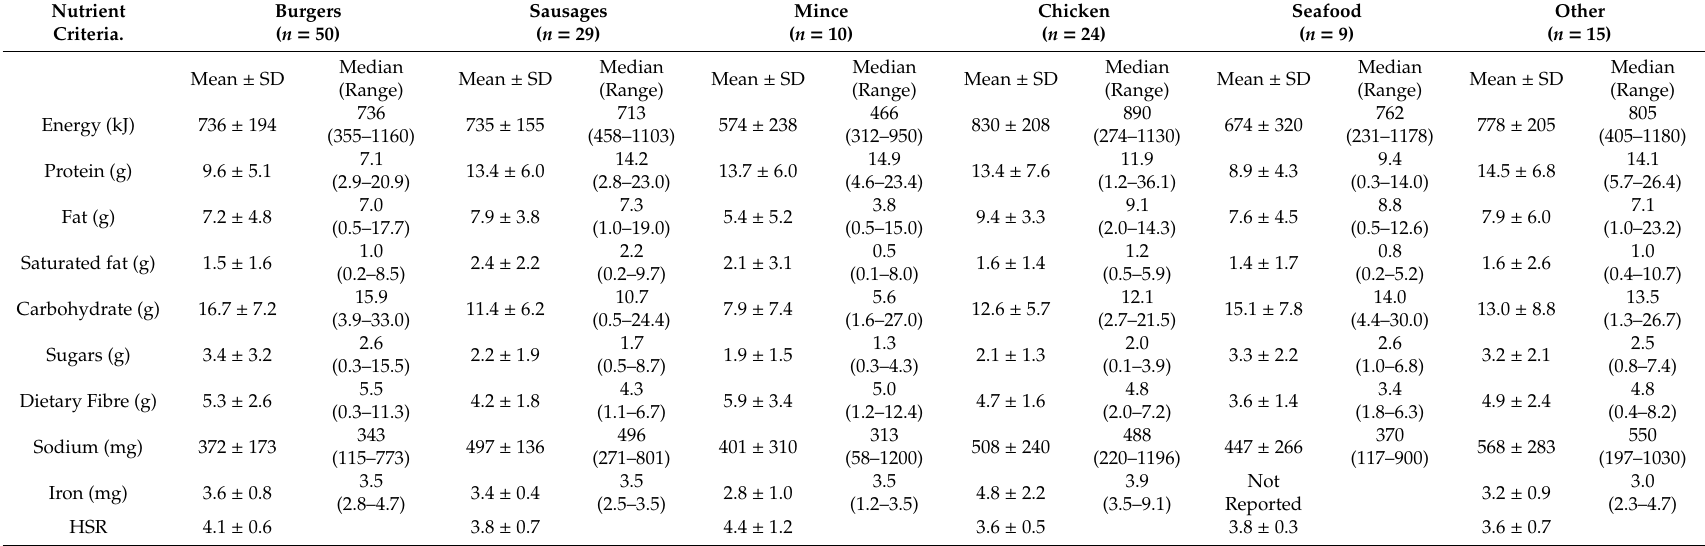
Table 3. Nutrients and Health Star Rating (HSR) per 100 g plant-based burgers, sausages, mince, chicken, seafood, and other plant-based meats (mean ± standard deviation (SD) and median